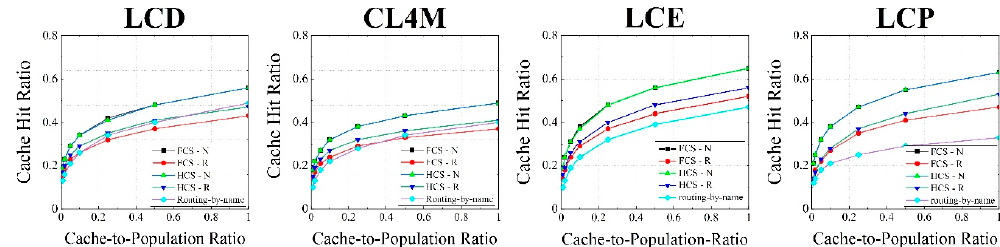
Figure 8. Comparison of cache-hit ratios with cache-to-population ratios {0.01, 0.02, 0.05, 0.1, 0.25, 0.5, and 1}.